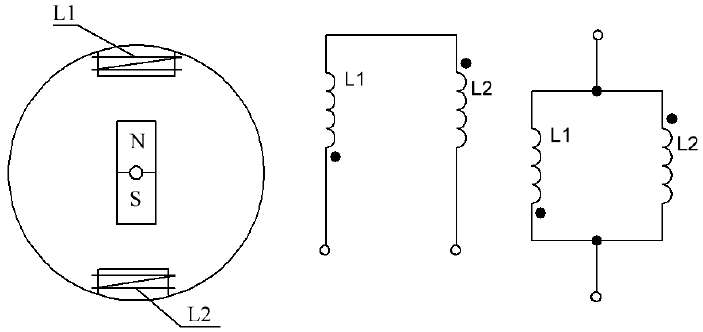
Figure 1. Generator with a simplified construction.